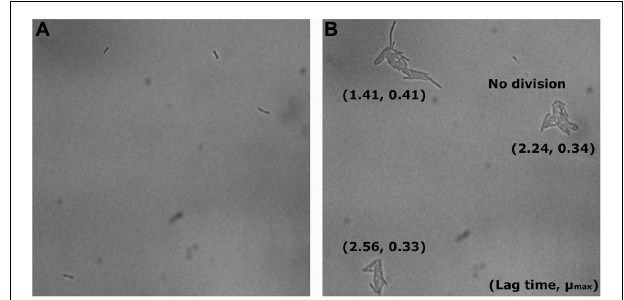
FIGURE 6 | Example of neighboring cells of JK09 in the control experiment after anaerobic incubation at T = 0 (A) and T = 12 h (B).